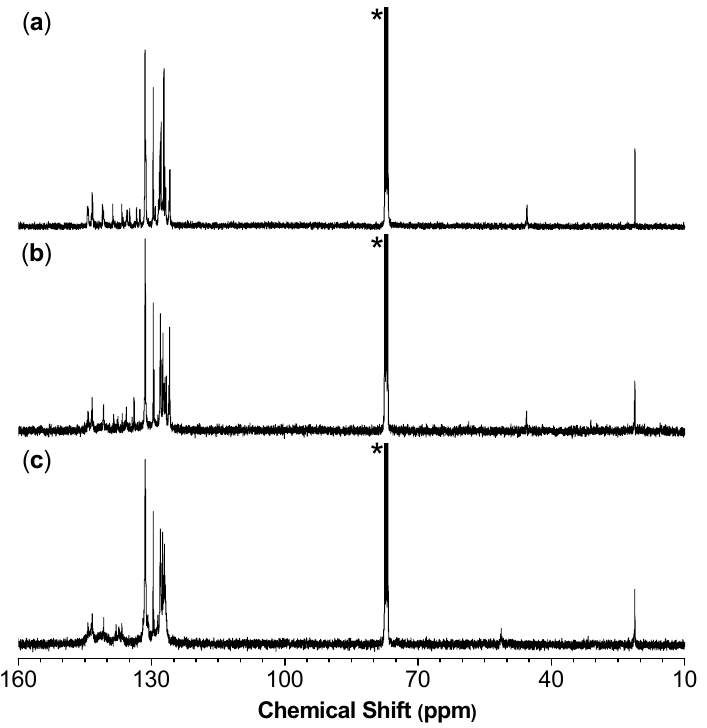
Figure 2. 13 C NMR spectra of ( a ) P 1 / 2 ; ( b ) P 1 / 2 -I (Table 1, no. 2) and ( c ) P 1 / 2 -II (Table 2, no. 3) in chloroform- d. The peaks related to chloroform- d are marked with asterisks.